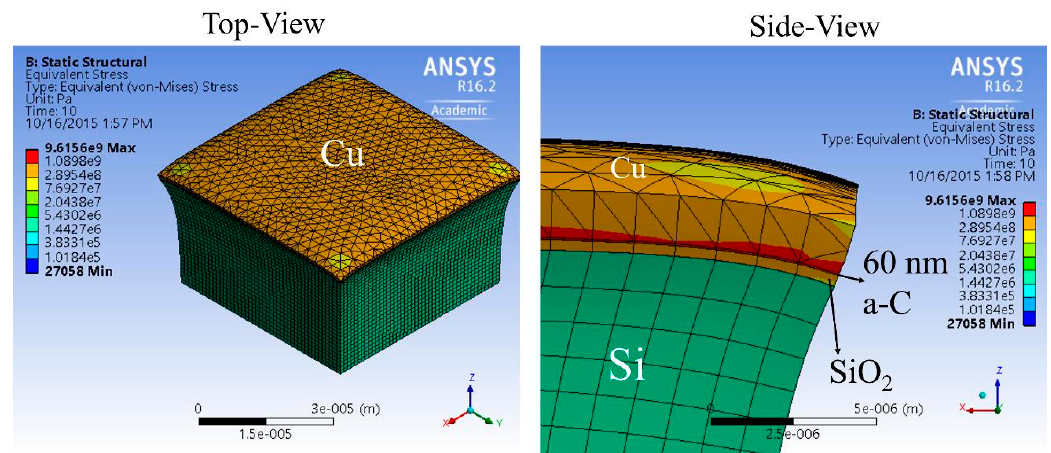
Figure 5. ANSYS simulation of thermo ‐ mechanical stress (equivalent von ‐ Mises stress) at the a ‐ C and Cu interface at 1020 °C.